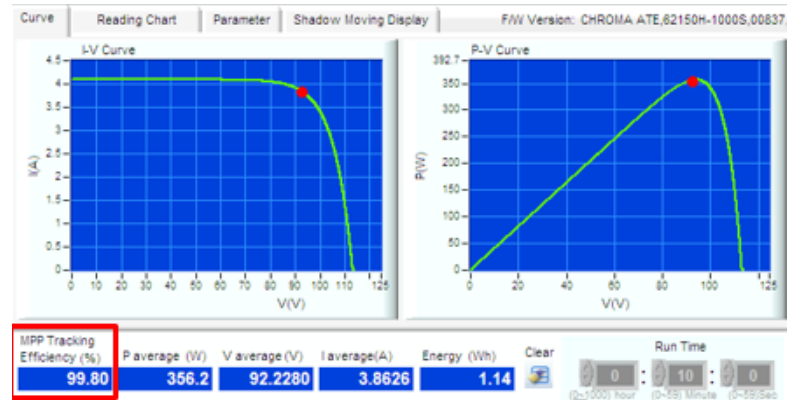
Figure 8. I-V curve and P-V curve of 667 W/m 2